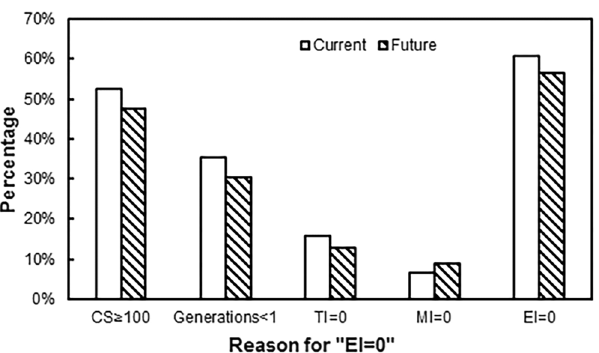
Figure 10. Percentages of four different reasons for “EI = 0” under current and future climate. “Percentage” represents for the proportion of grid points which satisfy the condition to cause “EI = 0”. “generation < 1” means the climate data in this region couldn’t meet the development of a generation. “CS ≥ 100” means the species couldn’t survival in this region for cold stress. “TI” means Temperature Index, “MI” means Mositure Index. While “TI = 0” or “MI = 0” will cause the “GI = 0” (Growth Index) and lead to “EI =